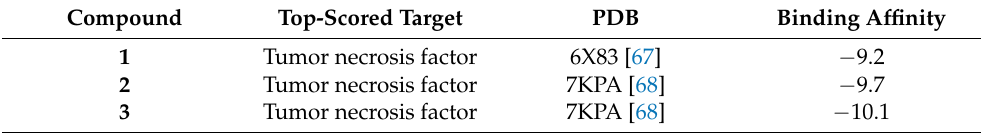
Table 3. Top-scoring target for each compound and the corresponding binding affinity. Compound